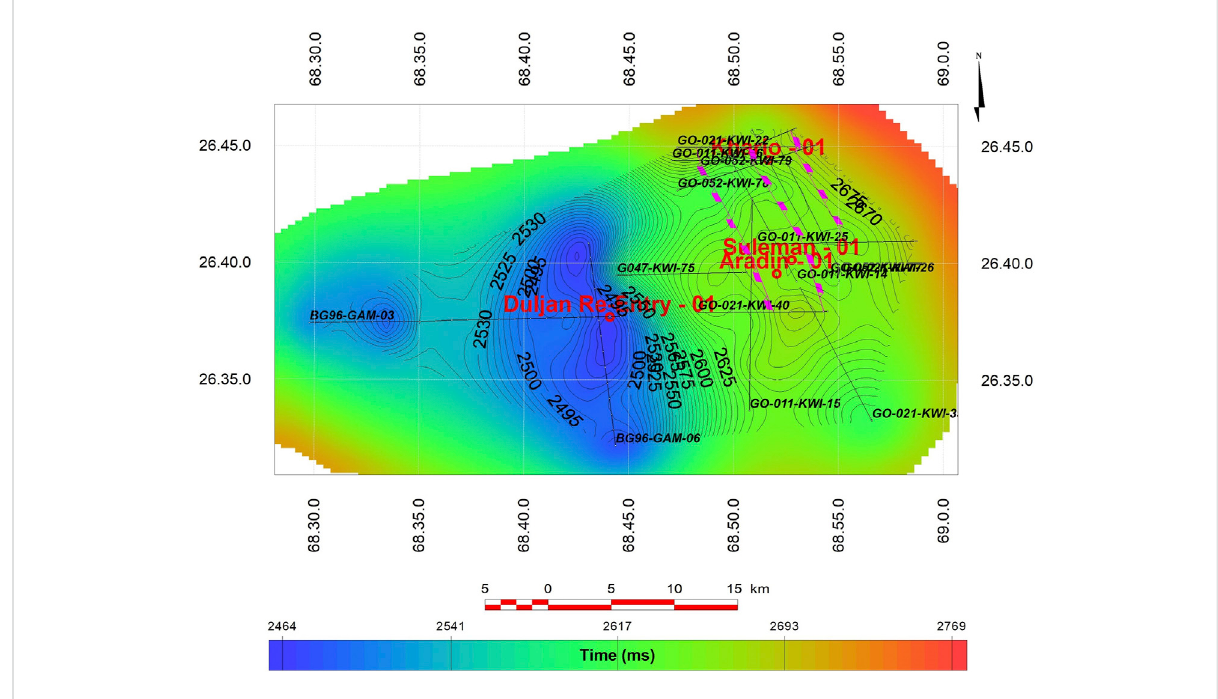
FIGURE 9 Two-way time structural map of sands of the Sembar